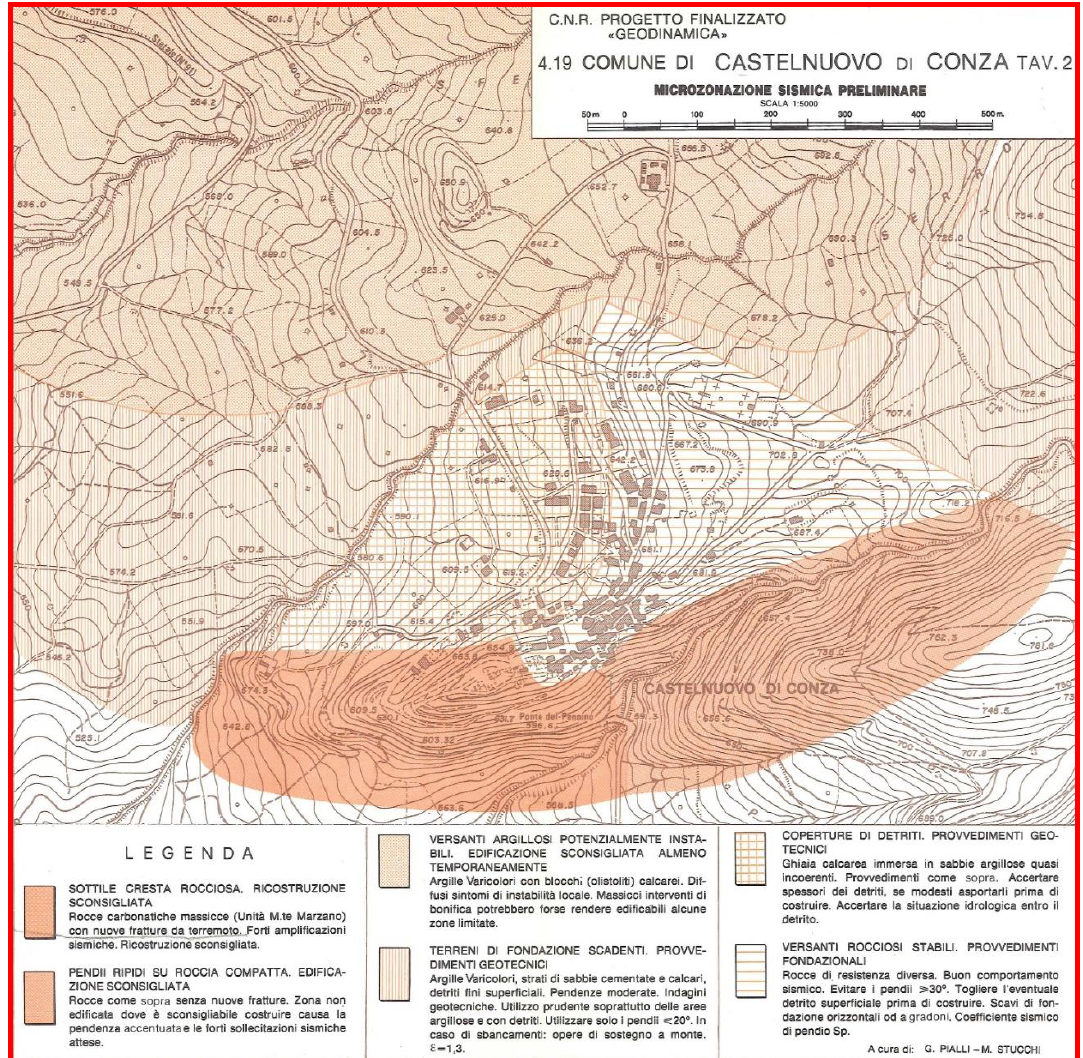
Figure 4. Original map of the seismic microzonation of Castelnuovo di Conza according to [29].